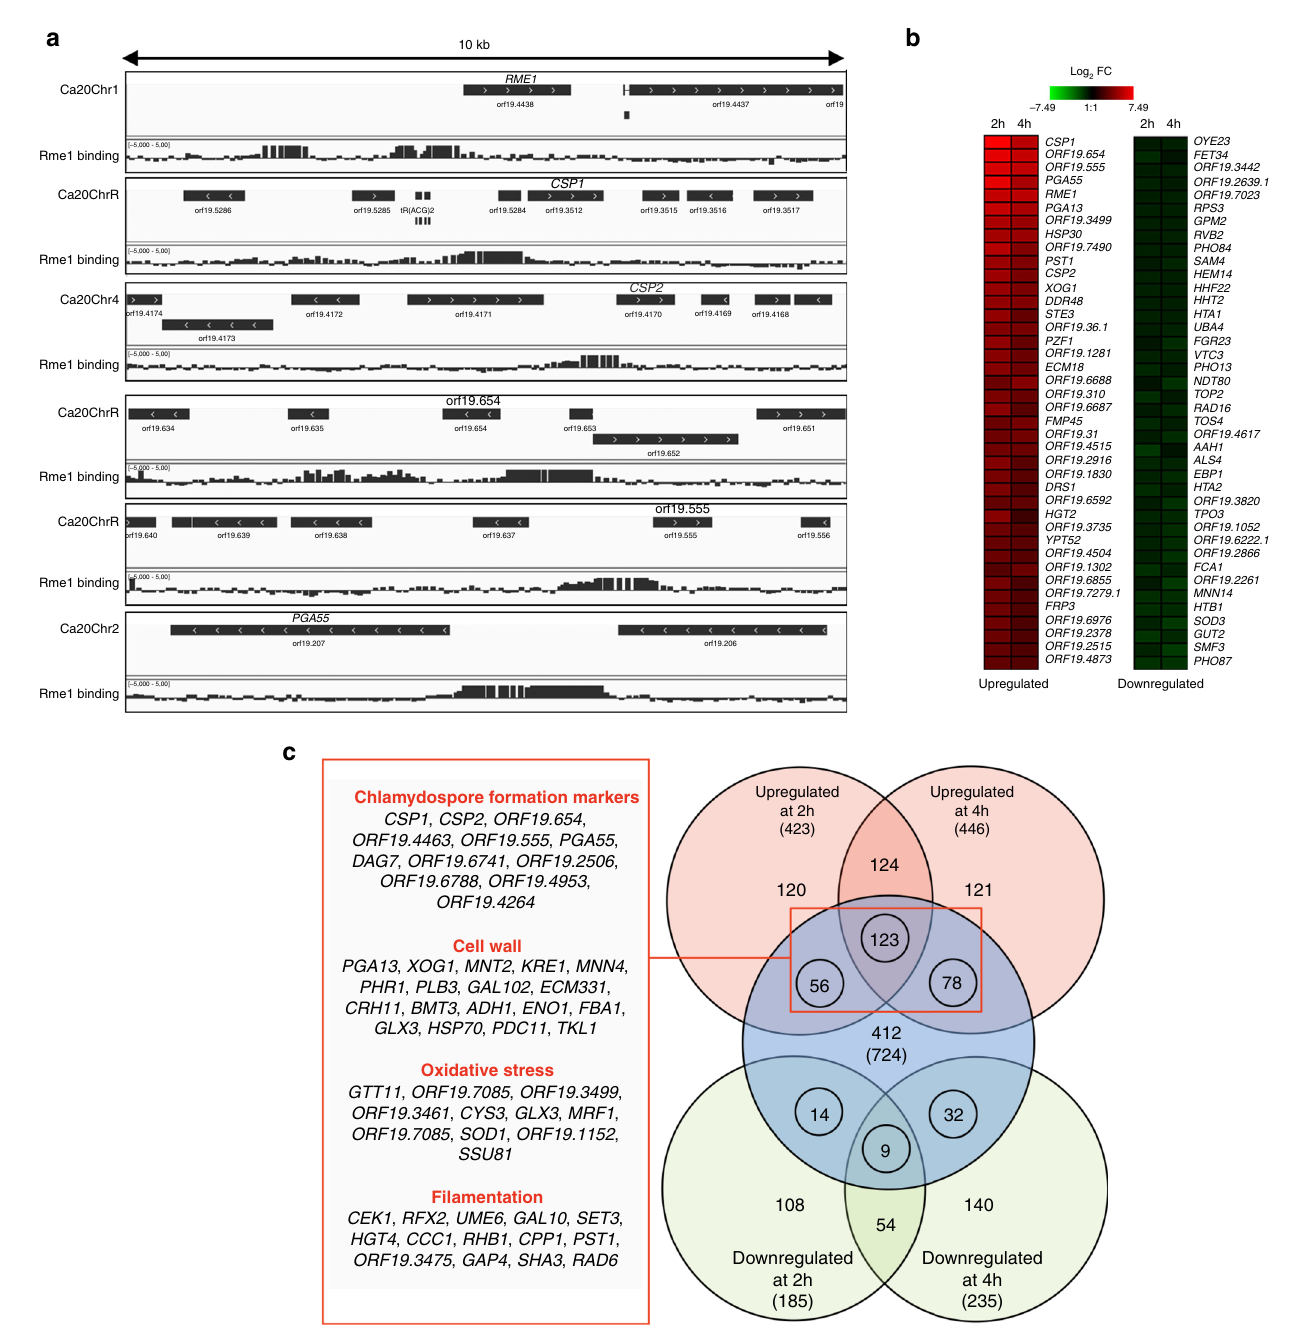
Fig. 1 C. albicans Rme1 is a positive regulator of chlamydospore formation markers. a Rme1 occupancies along 10-kb intervals of selected locations from the C. albicans genome (Assembly 20, the corresponding chromosome numbers are indicated on the left of each panel). The relative signal intensities of the 60-bp probes covering the whole C. albicans genome following enrichment of the rTAP-tagged Rme1-coimmunoprecipitated DNA relative to DNA from a mock immunoprecipitation (in an untagged strain background) are plotted. Data from one ChIP-chip experiment out of two are shown. The orientation of each ORF is depicted by the arrows in the black rectangles. Binding maps were generated using the IGV genome browser 61 . b Heat map showing the expression pattern in P TET - RME1 transcript pro fi ling data at time points 2 and 4 h after induction with 40 μ g/mL doxycycline. The heat map was generated with Genesis version 1.7.6 74 using the average expression level of three replicates. Genes were ranked according to average expression value between the two time points. c Venn diagram showing the overlap between genes transcriptionally modulated by P TET - RME1 at time points 2 and 4 h (gene expression fold-change ≥ 1.5 or ≤ − 1.5; P < 0.05, two-tailed Welch ’ s t -test, n = 3 independent biological samples) and bound by Rme1. Numbers in Venn diagram indicate the number of genes and those between parentheses indicate the total number of upregulated (light red circles), downregulated (light green circles) and bound (light blue circle) genes. Numbers within the circles indicate the number of genes that are both bound and transcriptionally modulated by Rme1. The name of few genes and their functional categories are shown in the linked red box (55 out of 257 bound and upregulated genes are shown). The ChIP-chip experiments was performed with two independent biological replicates, over two